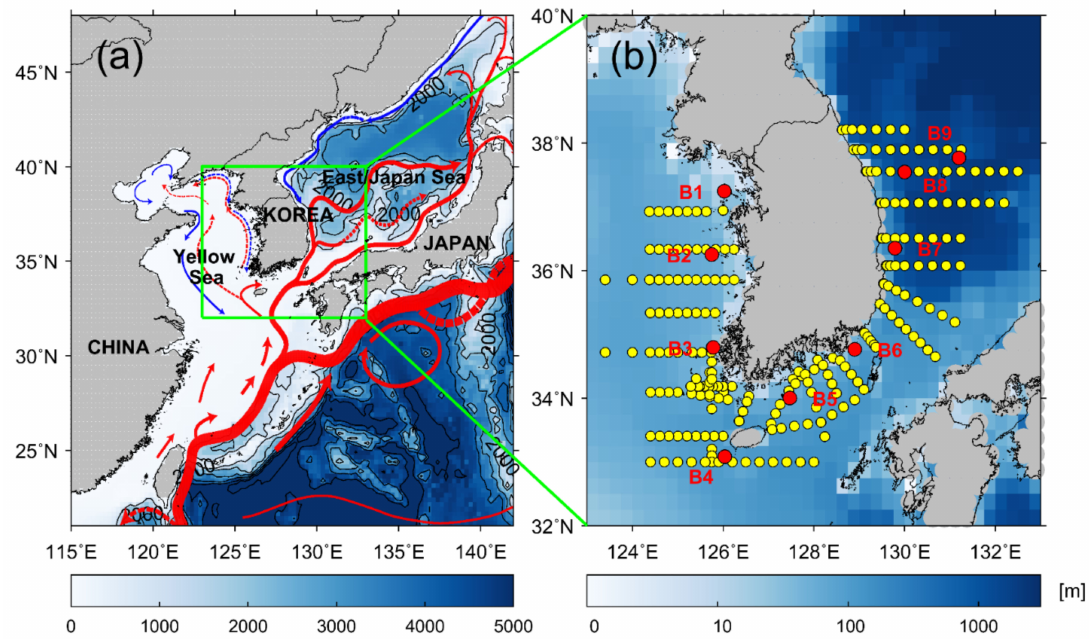
Figure 1. ( a ) Topography and surface currents [46] of the study area; ( b ) enlarged map for the seas around the Korean Peninsula, where the colored circles represent the location of the Korea Meteorological Administration (KMA) buoys (red) and the Korea Oceanographic Data Center (KODC) observation stations